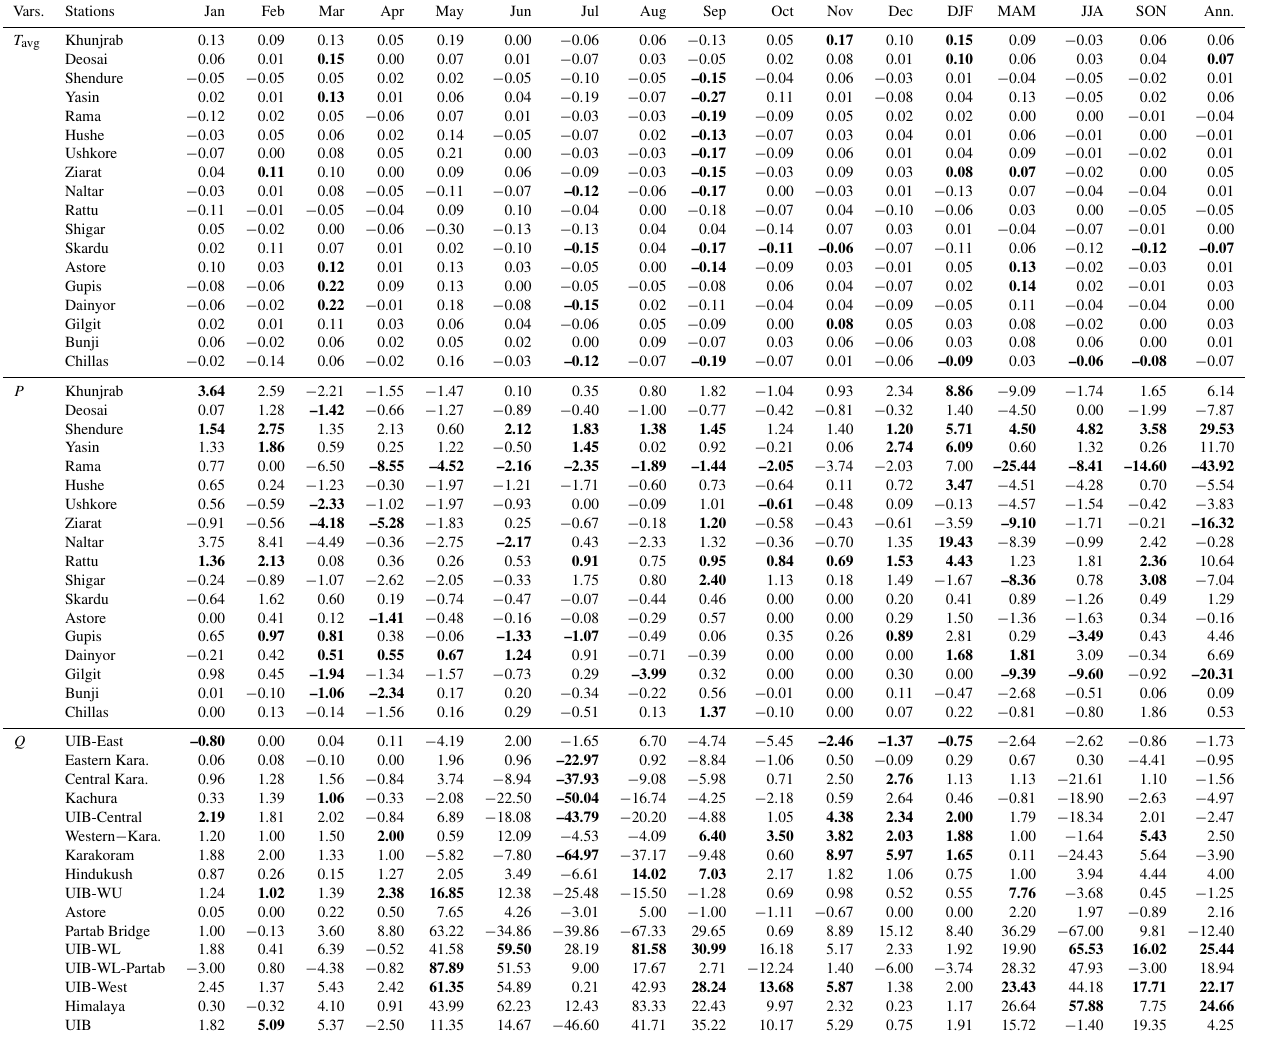
Table 5. Same as Table 4. Here, slopes for P are in mm and for Q in m 3 s − 1 . Hydrometric gauges are given in downstream order. Vars.